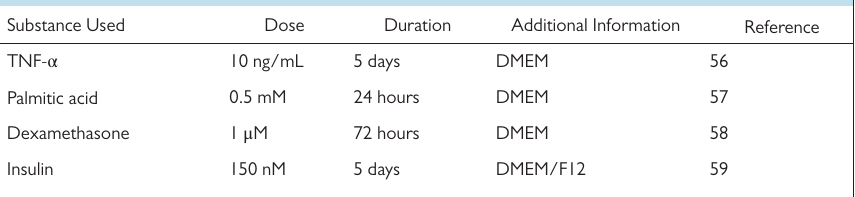
Table 4. Insulin Resistance Procedures in 3T3-L1 Cell Lines Substance Used